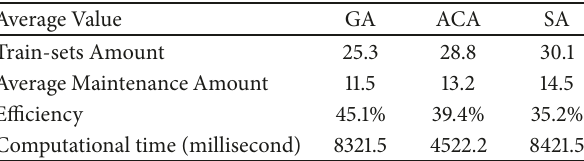
Table 5: Results of different